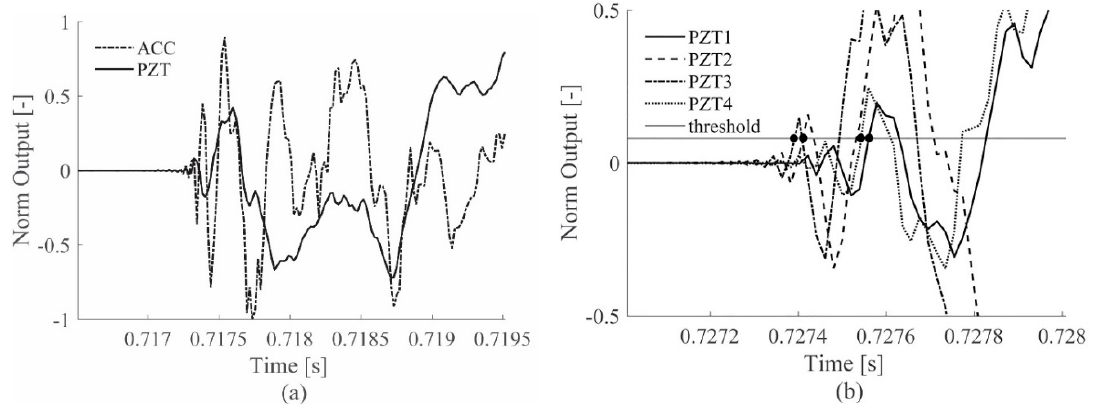
Figure 2. Original signals during an impact event for ACC and PZT sensors, on the aluminum plate ( a ) and the TOA measurement with multiple PZTs on the same aluminum plate ( b ).